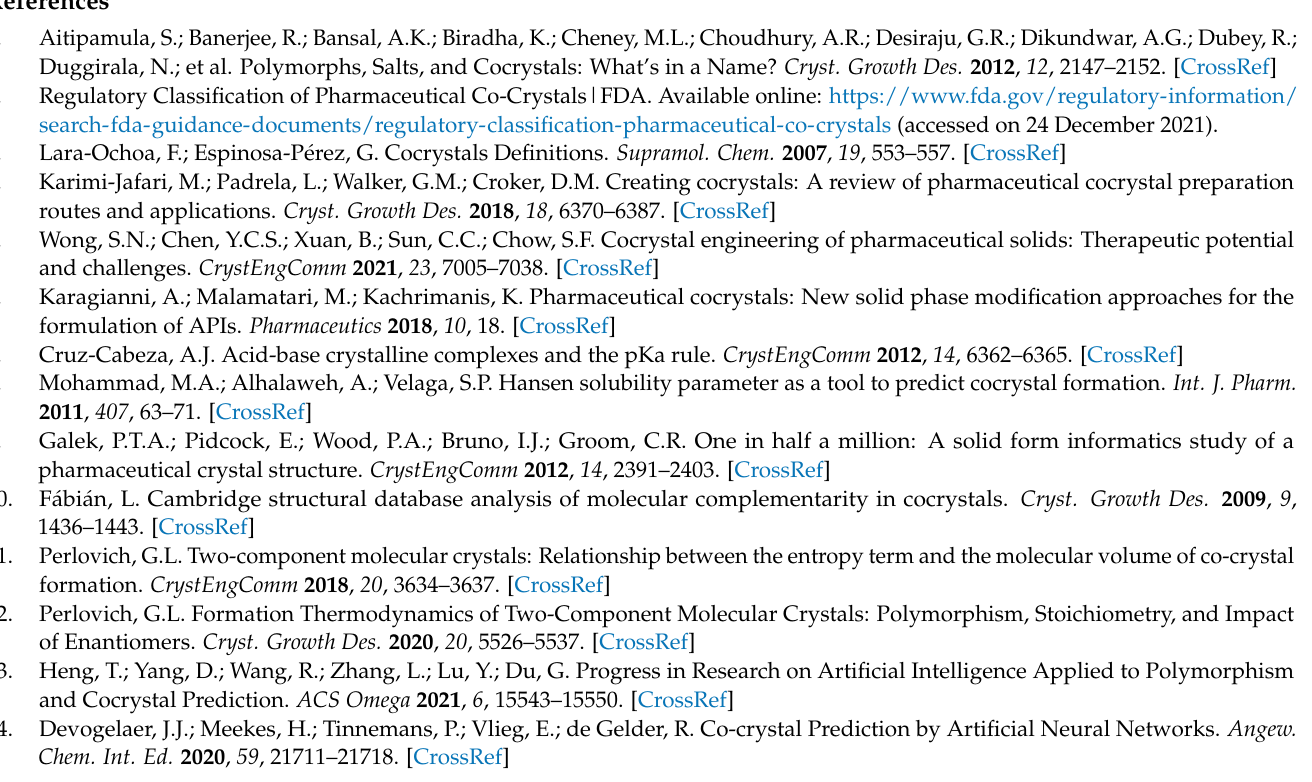
ENT and THP and the ∆ δ and Ra value calculated by Hoftyzer–Van Krevelen group contribution method.; Table S2. Multicomponent score and highest propensity values for ENT (A) and coformers (B), obtained by HBP analysis; Table S3. Results of QM/MM geometry optimizations of crystal structure; Table S4. Correlation coefficient values of different mechanistic kinetics models for the dehydration process of ENT-THP-water 1:1:1 cocrystal.; Table S5. Packing analysis for possible π - π interactions for ENT and THP in ENT-THP-water 1:1:1 cocrystal.; Table S6. Packing analysis for possible Y-X . . . π interactions for ENT and THP in ENT-THP-water 1:1:1 cocrystal; Scheme S1. Graphical presentation of the parameters used for the description of π - π stacking with the aid of